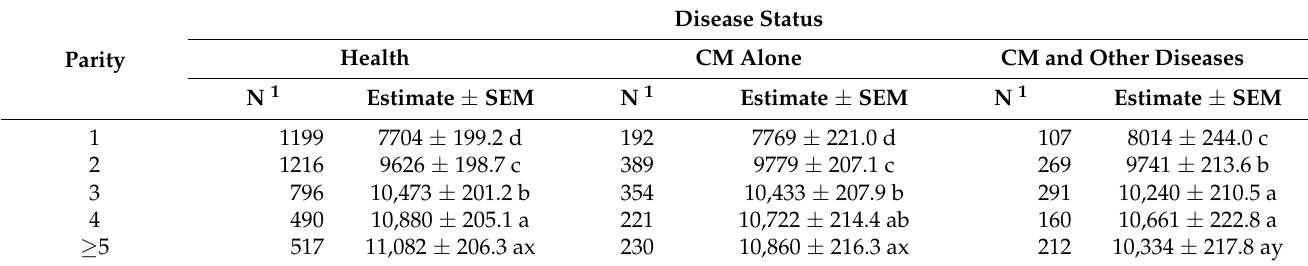
Table 4. Multivariable models comparing 305-day milk yield to clinical mastitis (CM) status and